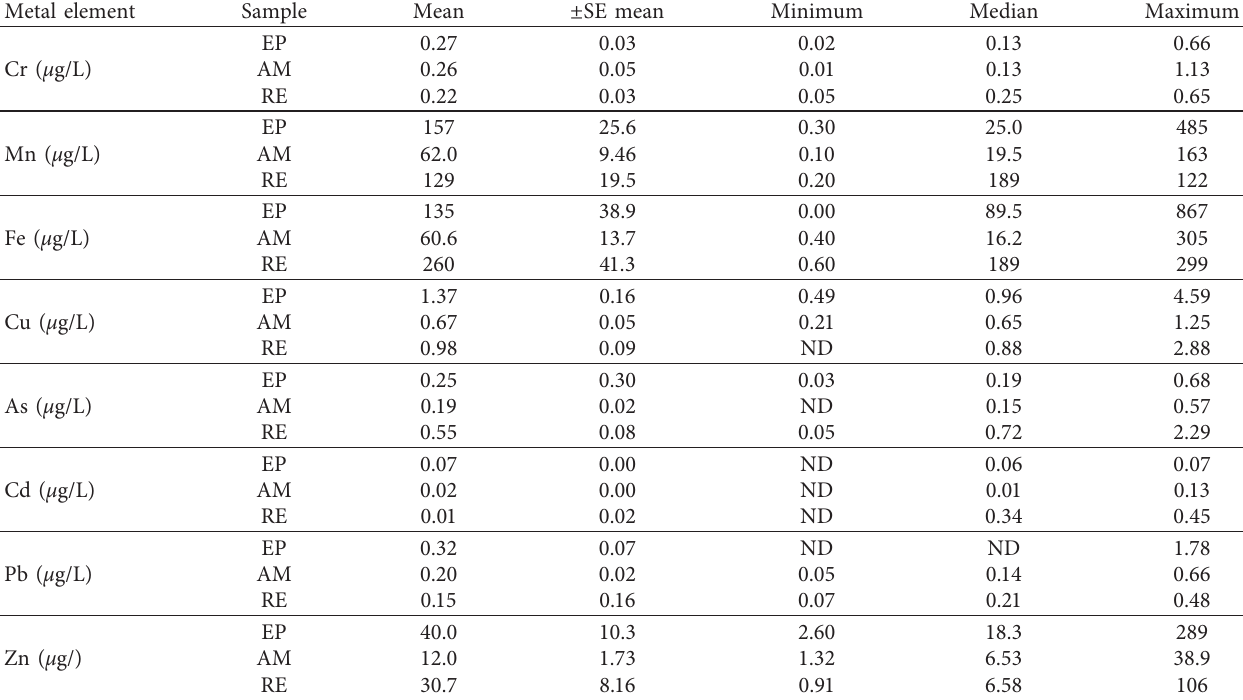
Table 3: Statistical evaluation of concentrations of selected toxic metals/metalloids of the drinking water sources in the selected areas: Eppawala (EP) and Ambagaswewa (AM) GNDs and the reference (RE). Metal